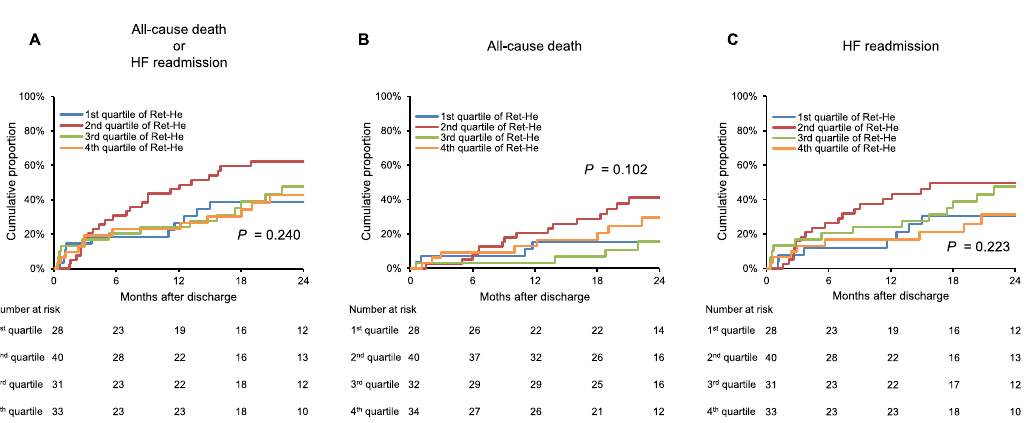
Figure 4. Survival curves for all-cause death or heart failure readmission according to quartile of Ret-He levels in HF patients. Kaplan–Meier analysis for ( A ) all-cause death or HF readmission, ( B ) all-cause death, and ( C ) HF readmission in HF patients by quartile of Ret-He